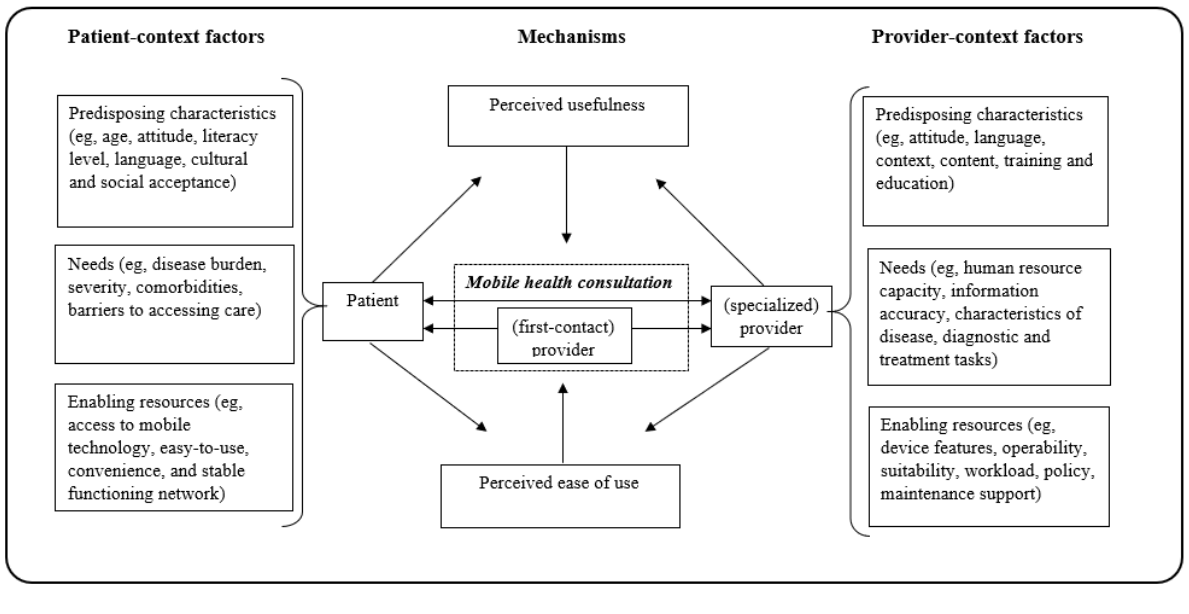
Figure 1. Mobile heatlh predisposing characteristics, needs, and enabling resources